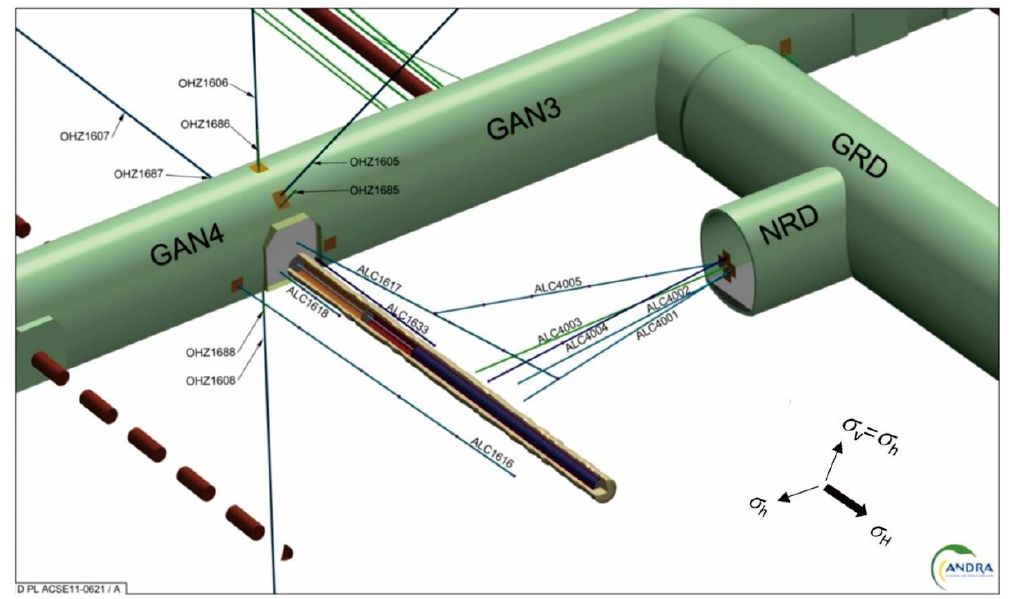
Figure 2. Schematic view of the ALC1604 heating test. Reprinted from [4,5] with permission from Elsevier.